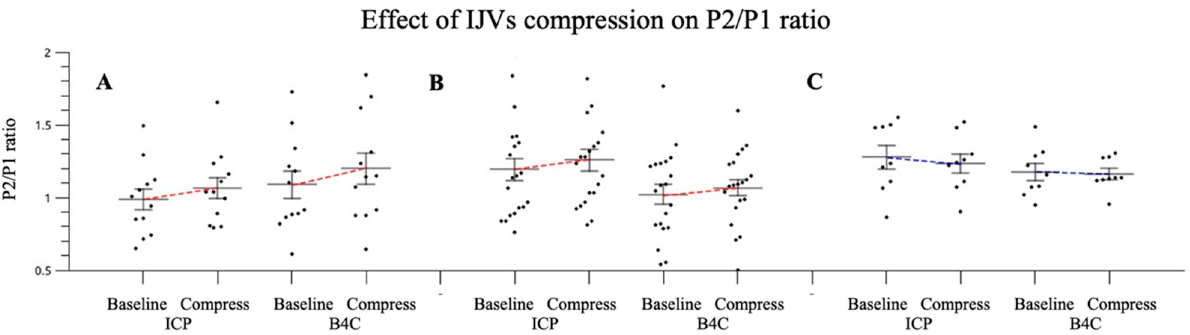
Figure 6. Dispersion plot for both techniques (ICP and B4C). P2/P1 ratio variation according to groups distribution: no cranial damage ( A , n = 12), craniotomy/large cranial fractures ( B , n = 20) and craniectomy ( C , n = 9), regarding ICP elevation intervention. ICP: intracranial pressure, IJVs: internal jugular veins.